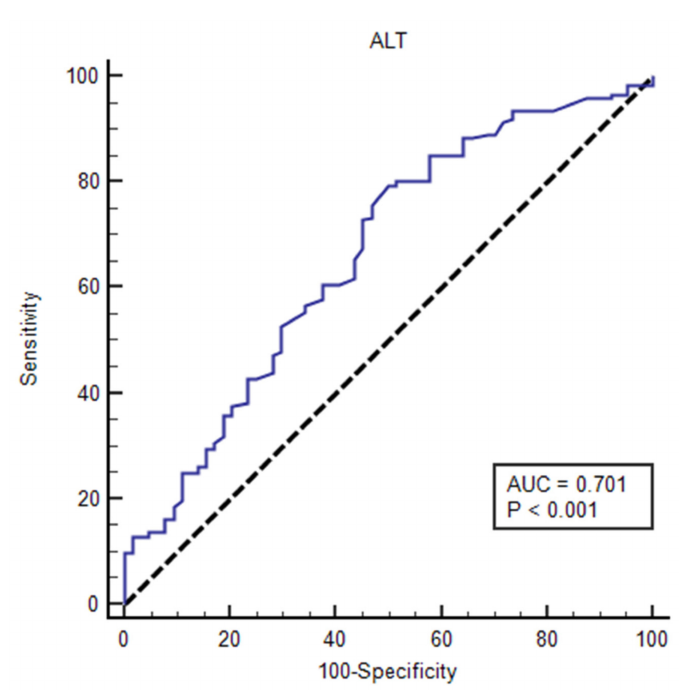
Figure 1. Receiver operating characteristic curve analysis of alanine aminotransferase (ALT) in IU / L to predict nonalcoholic fatty liver disease (NAFLD) among study sample of type 2 diabetes (T2DM) at Abha